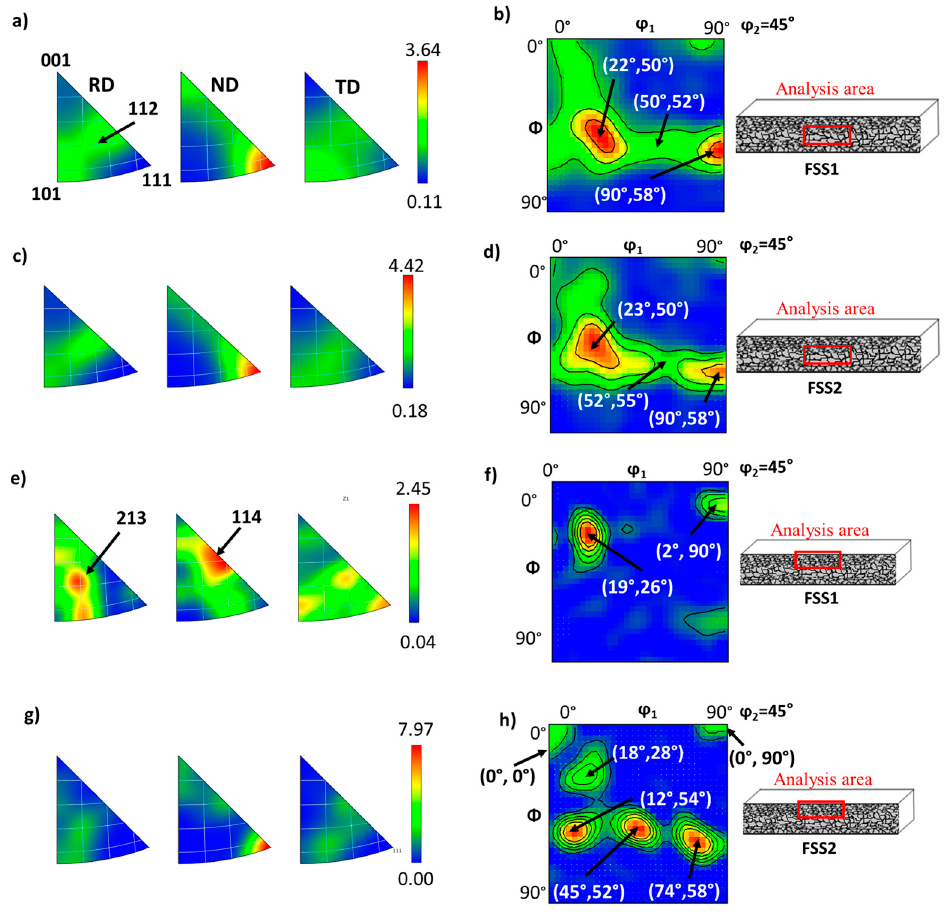
Figure 5. ( a ) Inverse pole figures (IPF) acquired on the FSS1 sample at the centre of the sheet, ( b ) corresponding orientation density function (ODF) map, ( c ) IPF acquired on the FSS2 sample at the centre of the sheet, ( d ) corresponding ODF map, ( e ) IPF acquired on the FSS1 sample at the surface of the sheet, ( f ) corresponding ODF map, ( g ) IPF acquired on the FSS2 sample at the surface of the sheet, and ( h ) corresponding ODF map.